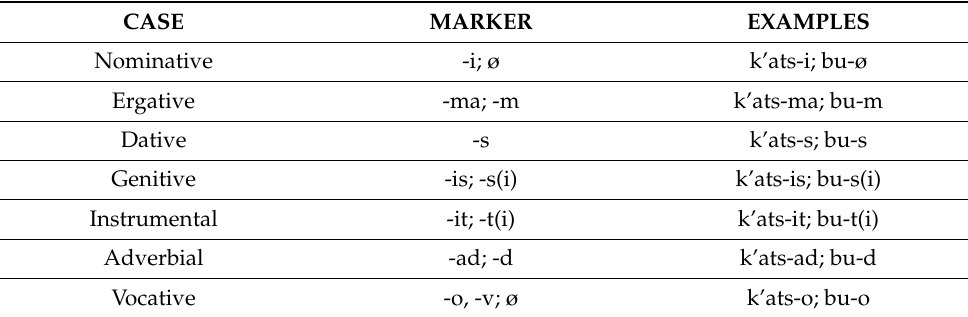
Table 8. Cases in Georgian.